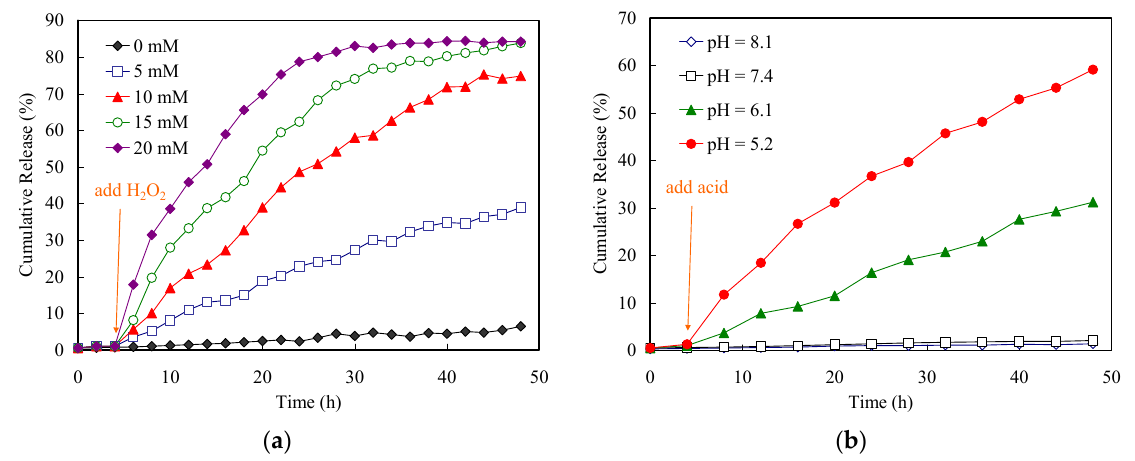
Figure 5. ( a ) Cumulative release of FITC-vancomycin from the hole array capped by P(MAA-DB)- BDA in the presence of ( a ) H 2 O 2 at various concentrations and ( b ) aqueous solution at various pH values. H 2 O 2 was added and pH values was changed after 4 h.